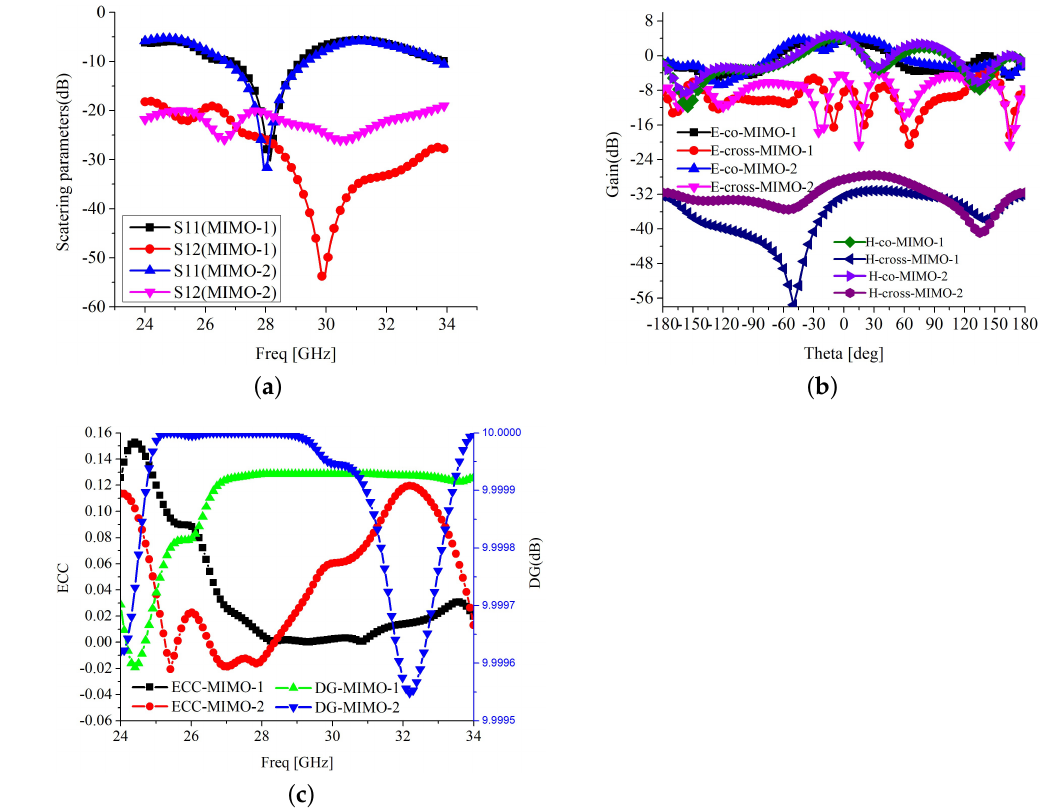
Figure 11. Comparative results of MIMO 1 and 2 configurations ( a ) S-parameters ( b ) Radiation pattern ( c ) MIMO performance parameters.